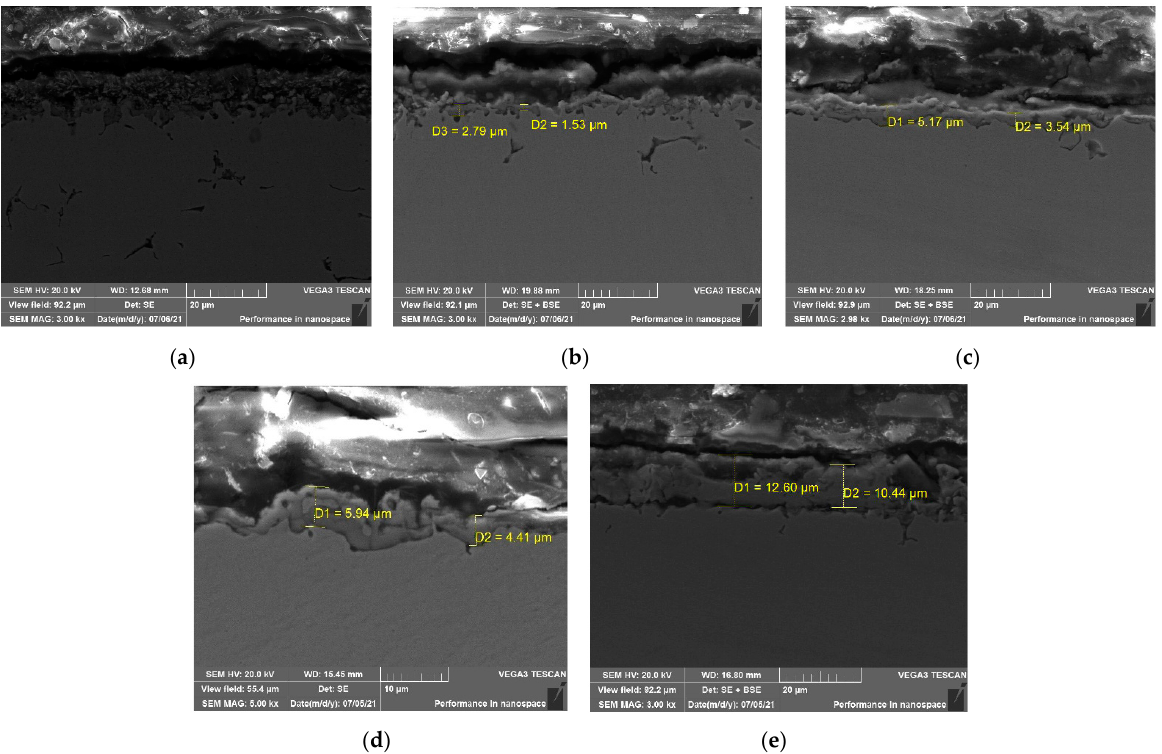
Figure 6. SEM cross section morphology of mullite films after sintering with different layers: ( a ) uncoated; ( b ) single-layer; ( c ) three-layer; ( d ) six-layer; ( e ) nine-layer. Figure 7 is the EDS line scanning analysis of a sample with three layers. There are two peaks of Si element on the outmost layer. The width of Si peak was about 3 µ m.